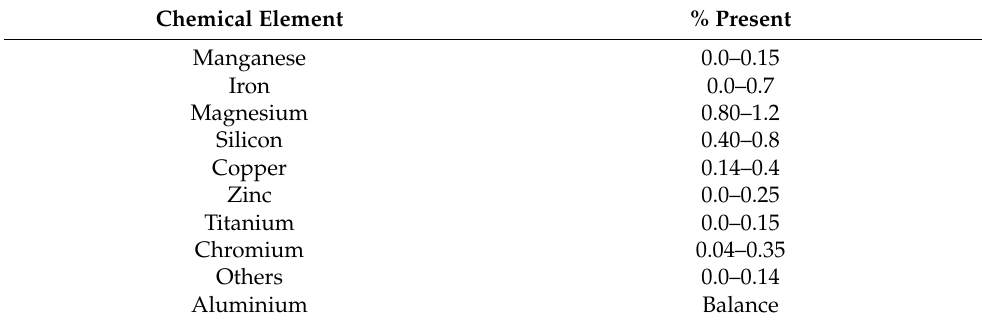
Table 1. Chemical composition of AA6061.